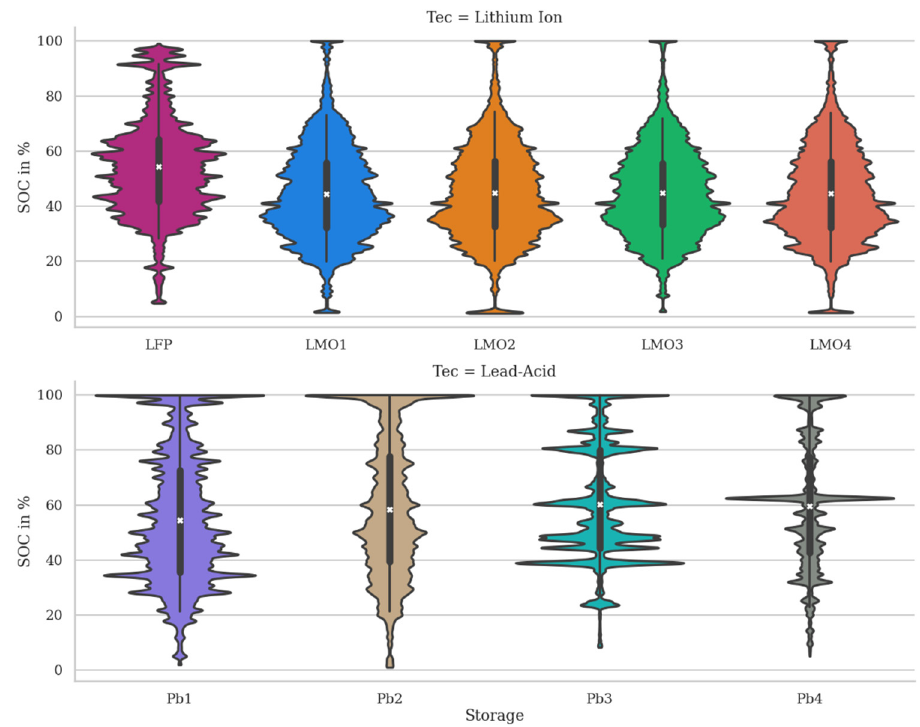
Figure 7. Distribution of the SOC for the different battery units.